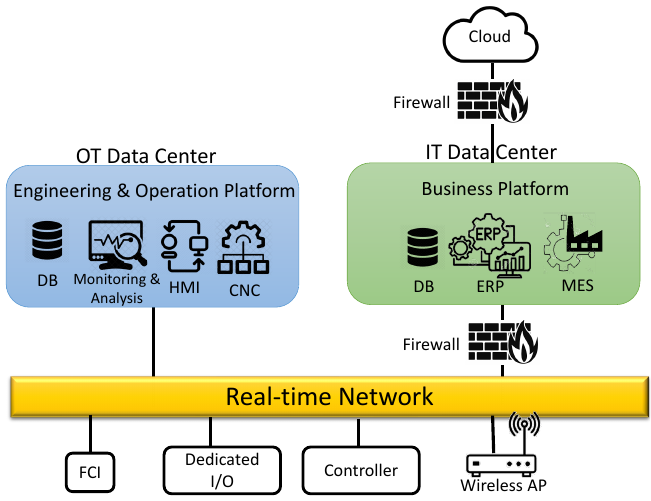
Figure 2. The future control